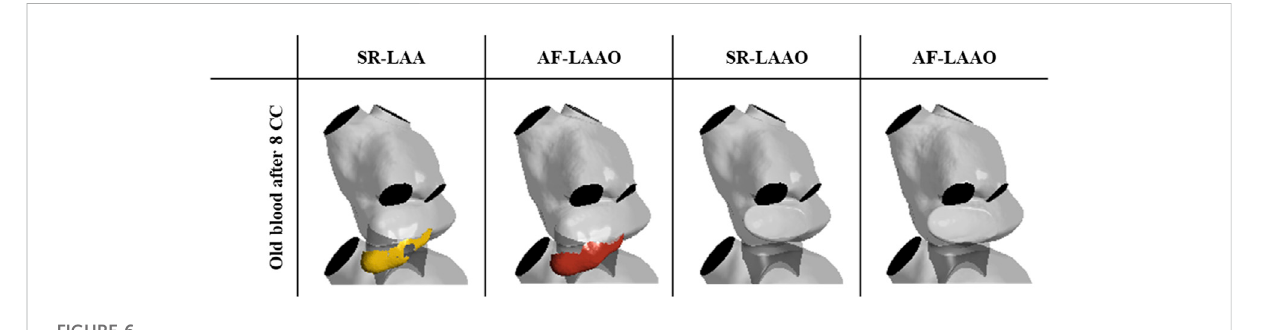
FIGURE 6 Volume of the old blood remaining in the LAA after 8 cardiac